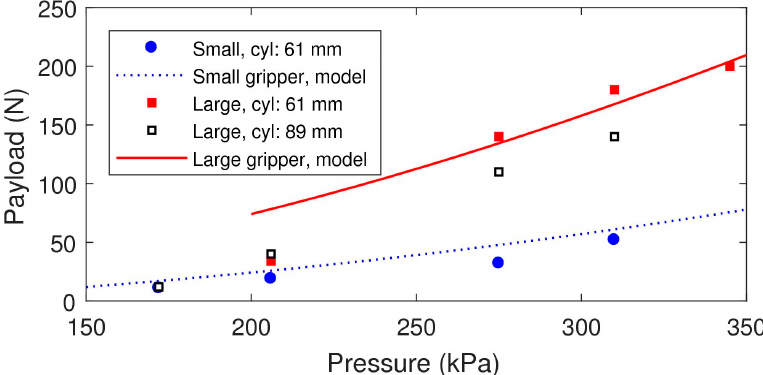
Figure 10. Gripping payloads (experimental and model predictions) for both grippers (small and large) at various operating pressures for two cylinder diameters. The lowest payload of three experiments for each set of conditions is